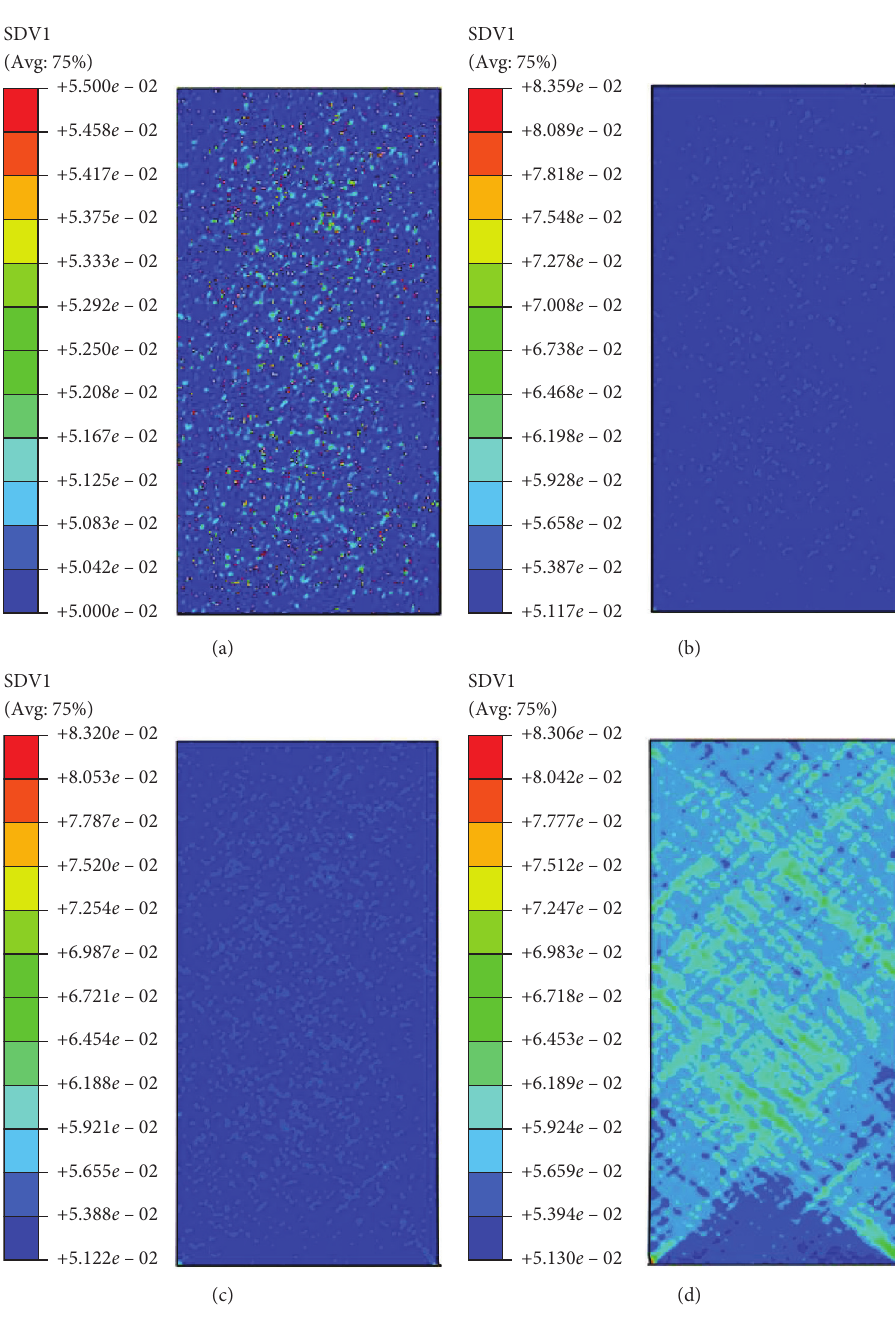
Figure 3: Contours plot of the shear banding evolution in the samples at different strains under tensile loading. (a) ε � 0%; (b) ε � 2.25%; (c) ε � 2.48%; (d) ε �